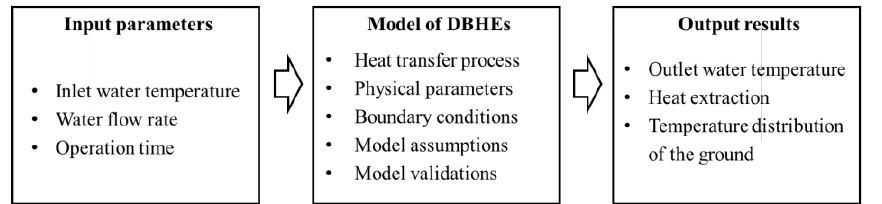
Figure 3. Model of deep borehole heat exchangers